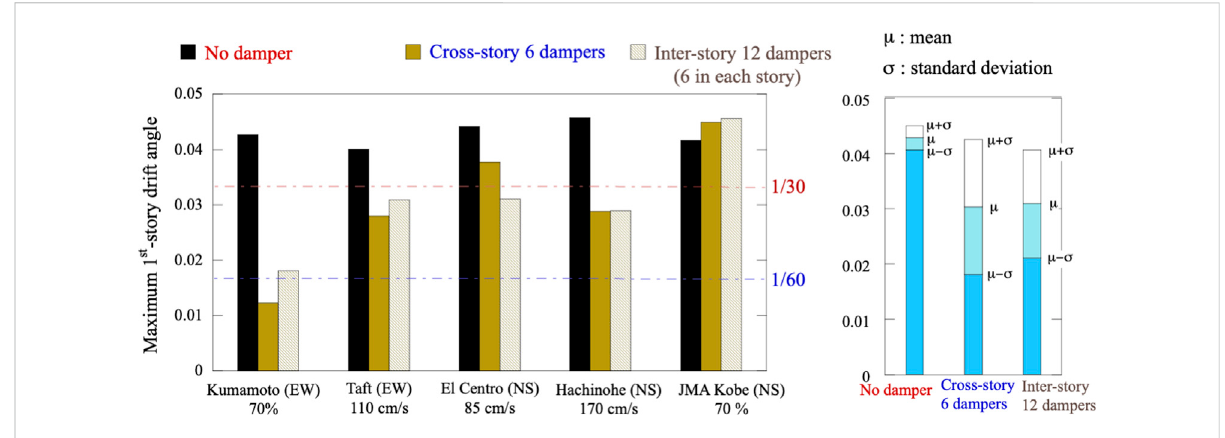
FIGURE 11 Maximum fi rst-story drift angles of the timber house model with and without